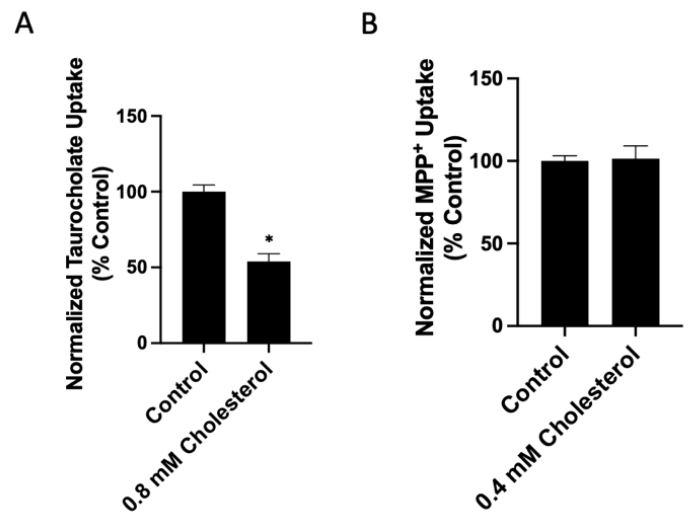
Figure 5. Normalized NTCP- and OCT1-mediated uptake after treatment with cholesterol. Uptake of ( A ) 100 µM [ 3 H]-taurocholate by NTCP- and ( B ) 16.7 nM [ 3 H]-MPP + by OCT1-expressing HEK293 cells were corrected for surface expression. Net transporter-mediated uptake was calculated, and results are presented as percent of control; means ± SD of n = 3 in ( A ) or n = 4 in ( B ) are shown; asterisks indicate a p < 0.05.